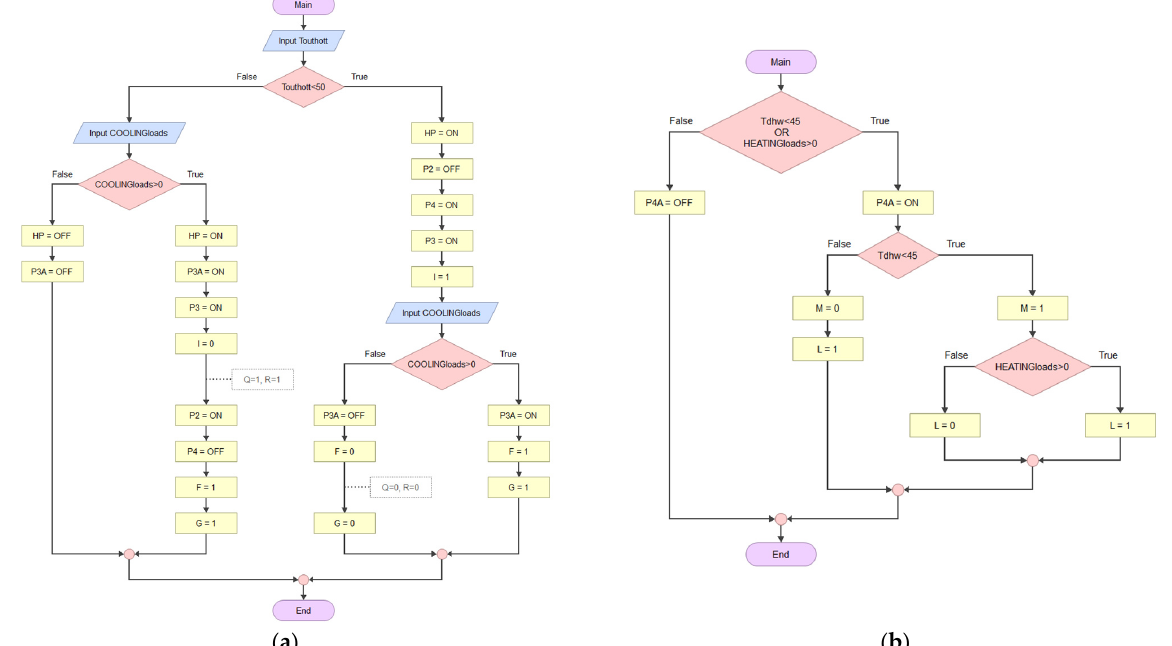
Figure 9. Flow charts of the control logic of HP–chiller loop ( a ) and heating–DHW loop ( b ).